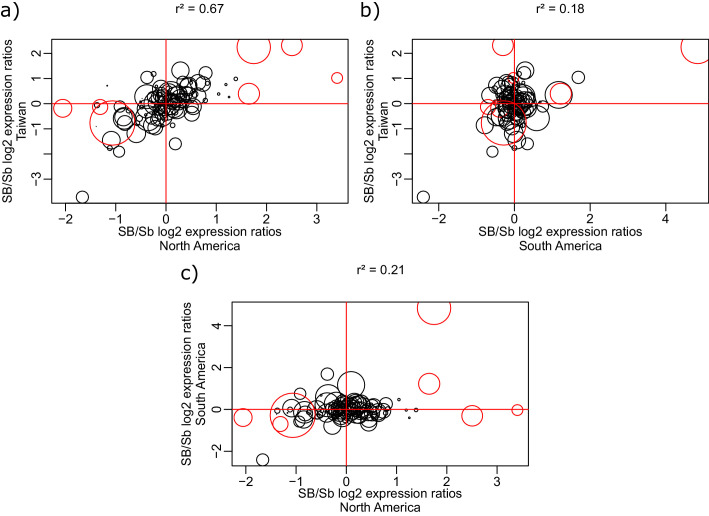
Correlation of log2 allele-specific expression ratios between the SB and Sb variants in heterozygous queens from three populations: South American data we generated, North American data (from Morandin et al., 2016), and Taiwanese data (from Fontana et al., 2020).We show correlations: (a) between Taiwanese and North American populations; (b) between Taiwanese and South American populations; and (c) between South American and North American populations. Positive values represent higher expression of the SB allele, negative values represent higher expression of the Sb allele. Each dot represents a single gene within the supergene region. The sizes of the dots are proportional to the average gene expression level. Red dots represent the genes detected by the linear mixed effects model as significantly differentially expressed between SB and Sb across populations. The correlation r2 between each pair of populations was calculated using the Spearman method, with each gene being weighted by mean expression level (read counts).